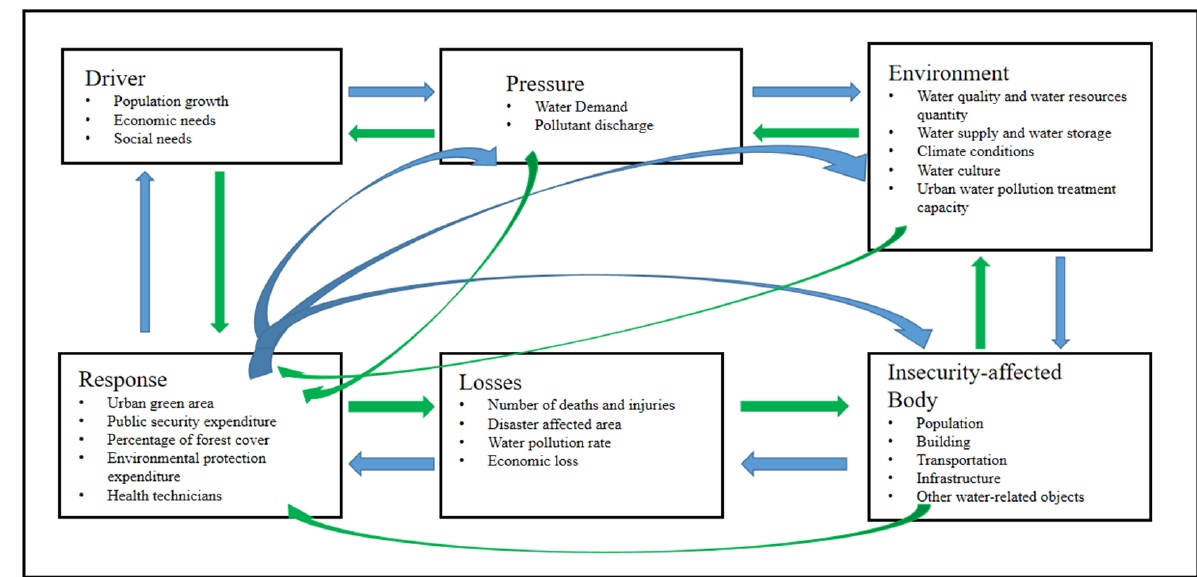
Figure 1. Urban Water Security Evaluation DPEBLR Conceptual Model.